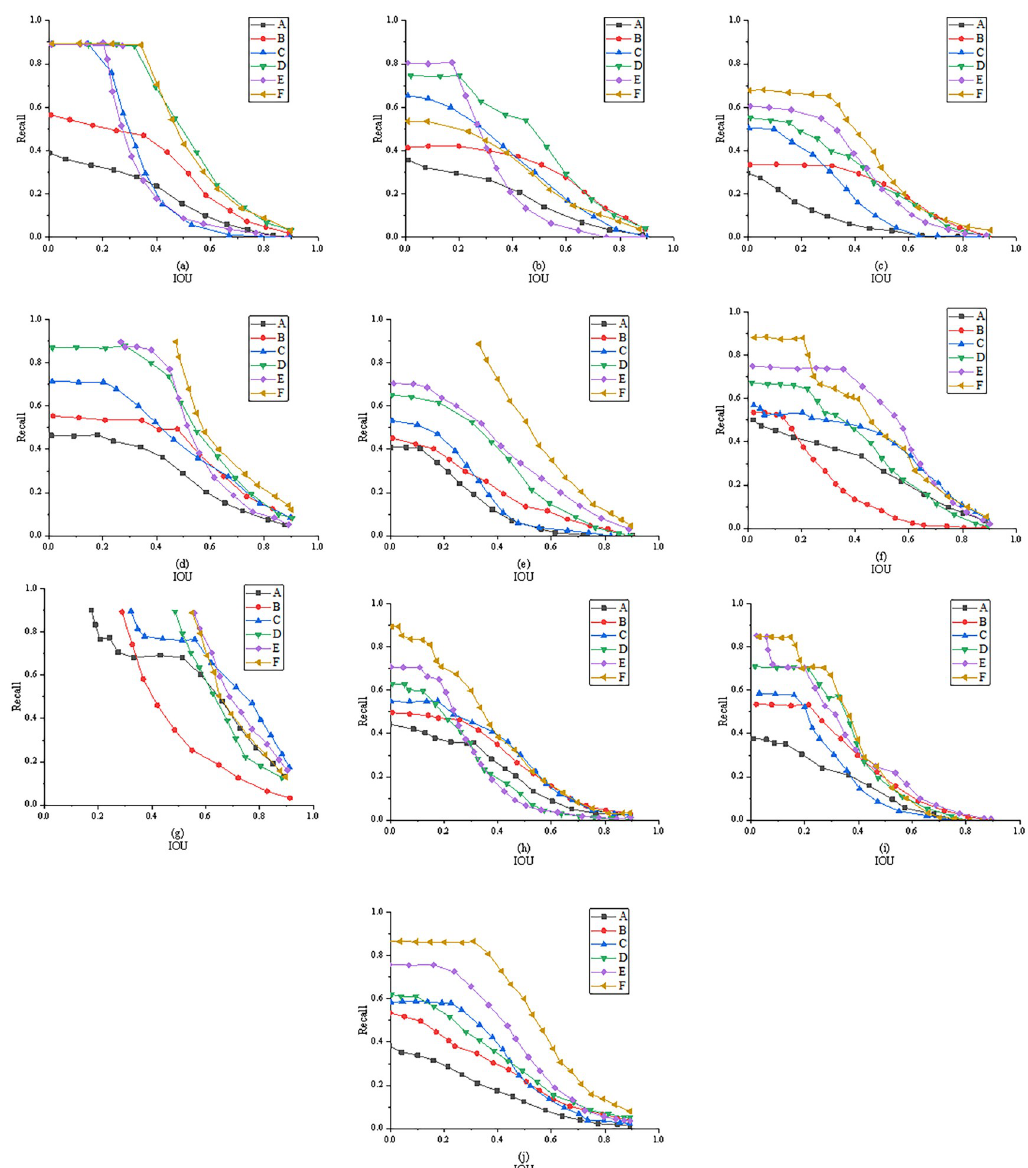
Fig 4. Recall/IoU curves of different comparison algorithms on VHR-10 data set (A: FRCN-ZF; B: FRCN-VGG; C: SSD; D: YOLO v1; E: YOLO-v5; F: YOLO-v5+ R-FCN; a: Aircraft; b: Boat; c: Storage tank; d: Baseball field; e: Tennis court; f: Basketball court; g: Track-and-field ground; h: Port; i: Bridge; j: Vehicle).